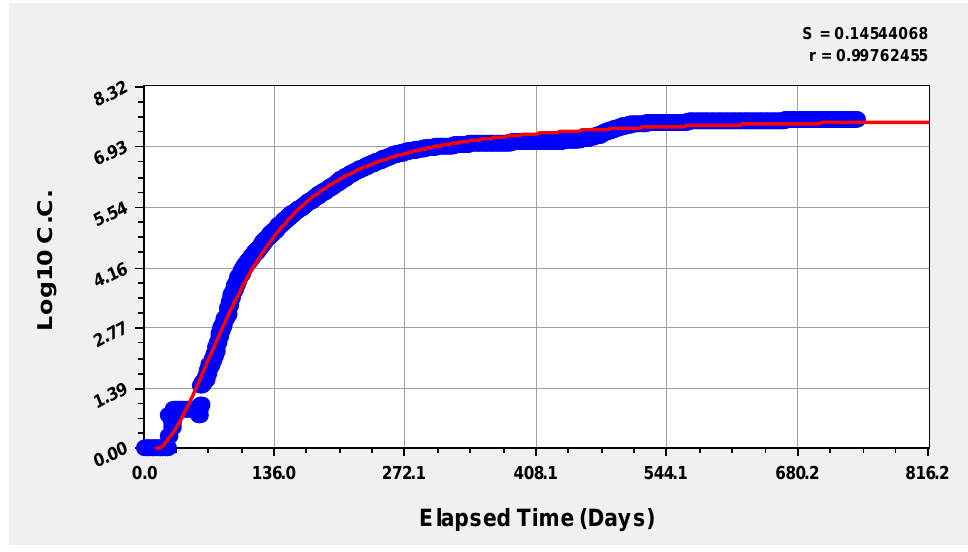
outbreak in India